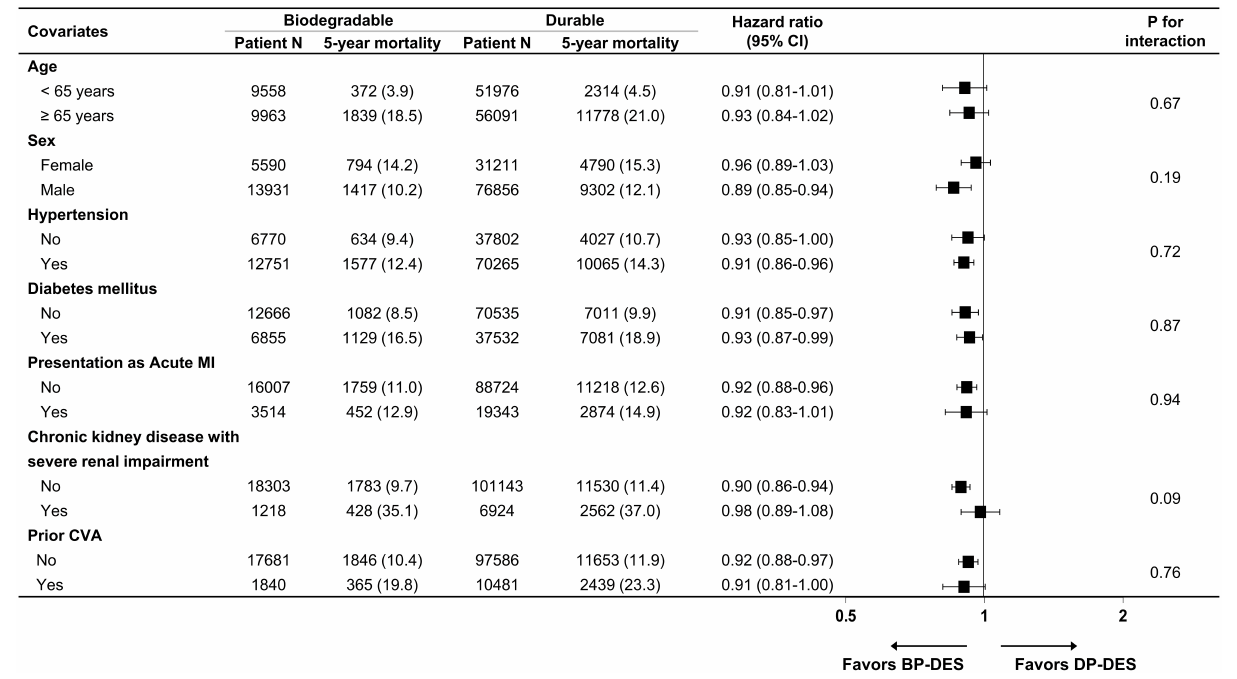
FIGURE 3 | Subgroup analyses for all-cause death. Numbers and percentages show the number of patients at risk, those who died with any cause of death, and the all-cause mortality rate at 5 years after drug-eluting stent implantation. CI, confidence interval; CVA, cerebrovascular accidents; BP-DES, biodegradable polymer